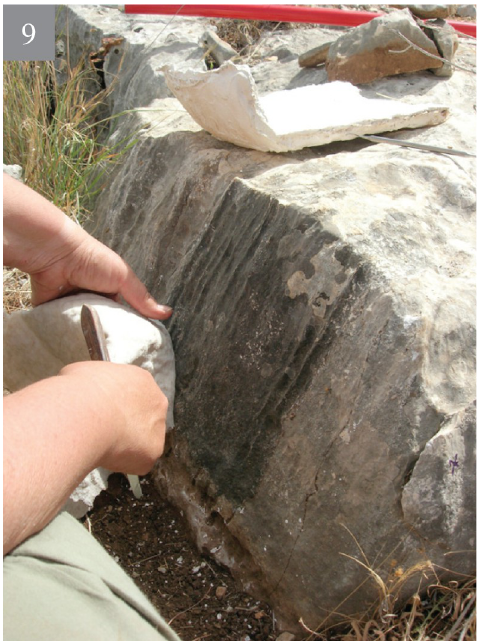
Fig 6. Rock damage resulting from flint quarrying of the Bi’na Formation bedrock (voids) and different types of quarrying marks